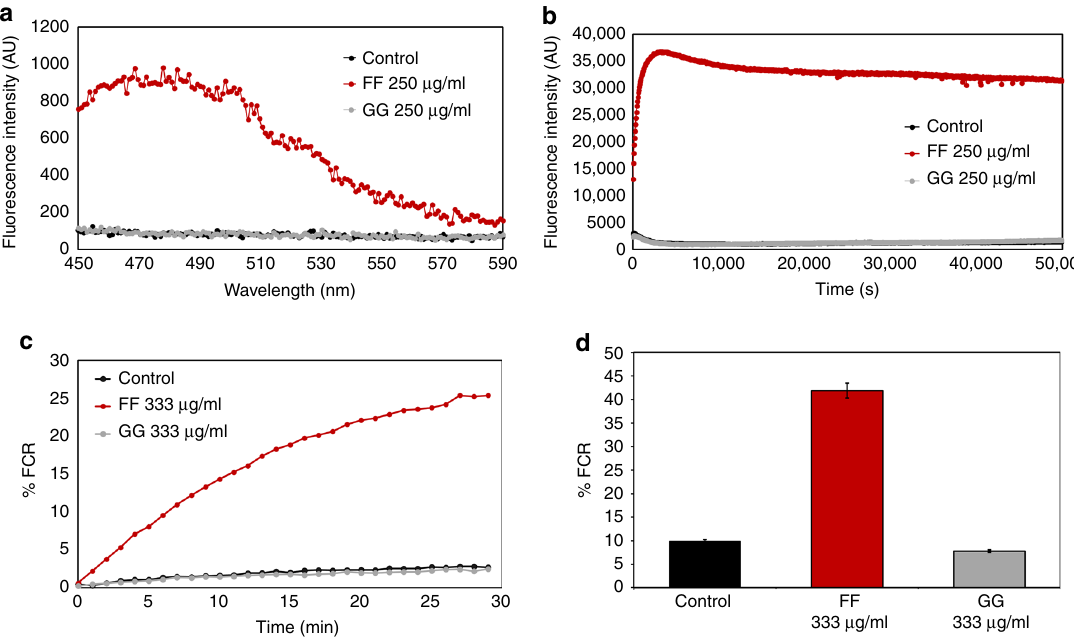
Fig. 2 The diphenylalanine nanostructures cause outer and inner membrane perturbations in E. coli and interact with model membrane systems. a Outer membrane permeation by the diphenylalanine nanostructures. Outer membrane permeation was determined using the ANS sulfonic amine fl uorescent probe that displays enhanced fl uorescence upon exposure of hydrophobic regions. b Cytoplasmic membrane depolarization by the diphenylalanine nanostructures. The cytoplasmic membrane depolarization activities were determined using the membrane potential sensitive dye DiSC3(5). c , d The diphenylalanine nanostructures interact with model phospholipid membrane systems. Membrane interactions of each compound were determined via measurements of the color transitions induced upon interaction of the compounds with DMPE/DMPG/PDA (1:1:3) vesicles. c Kinetics of the initial membrane interaction of the diphenylalanine nanostructures. d Interaction of the diphenylalanine nanostructures with the model membrane systems after incubation for 24